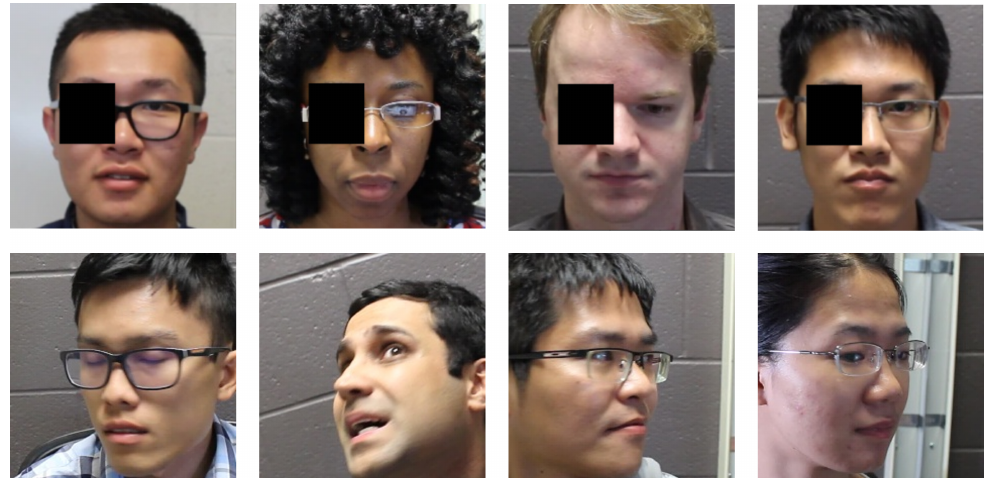
Figure 5. We test facial representations and symmetry capability with various modifications such as occlusions and varying facial poses. Here are examples of individuals both with eye occlusions as well as askance facial poses.